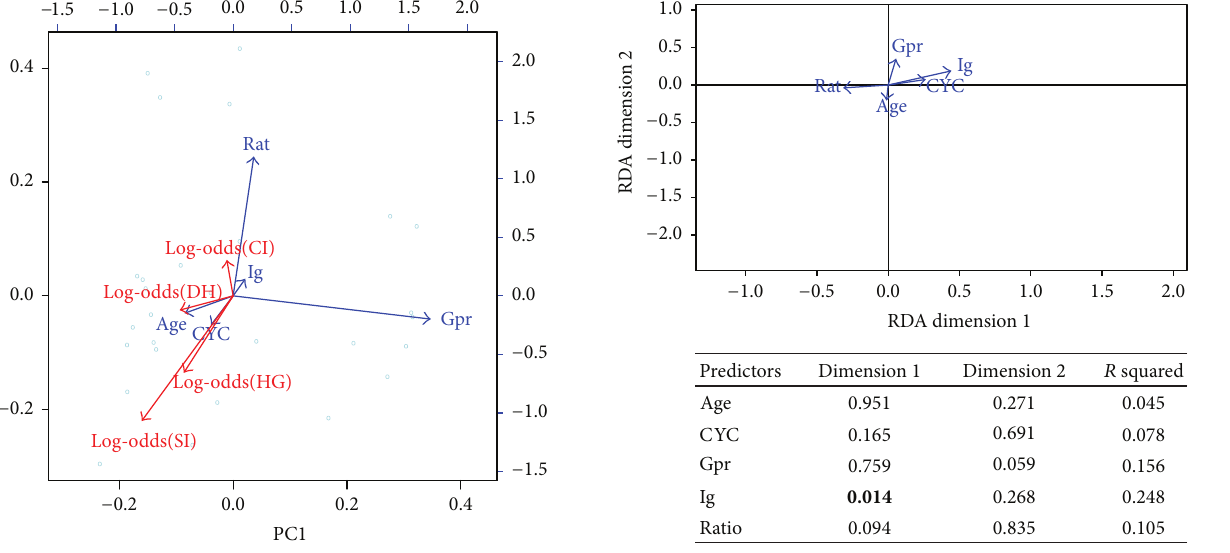
Figure 3: Two-dimensional biplot of adverse events using the principal component analysis of the five predictors. CI: chronic infection; CYC: cyclophosphamide cumulative dose; DH: discon- tinuation due to hypogammaglobulinemia; Gpr: gram of RTX per round; HG: hypogammaglobulinemia defined as total Ig < 6g/L; Ig: total level of immunoglobulin prior rituximab; Rat: ratio CD4/CD8 prior rituximab; SI: severe infection.